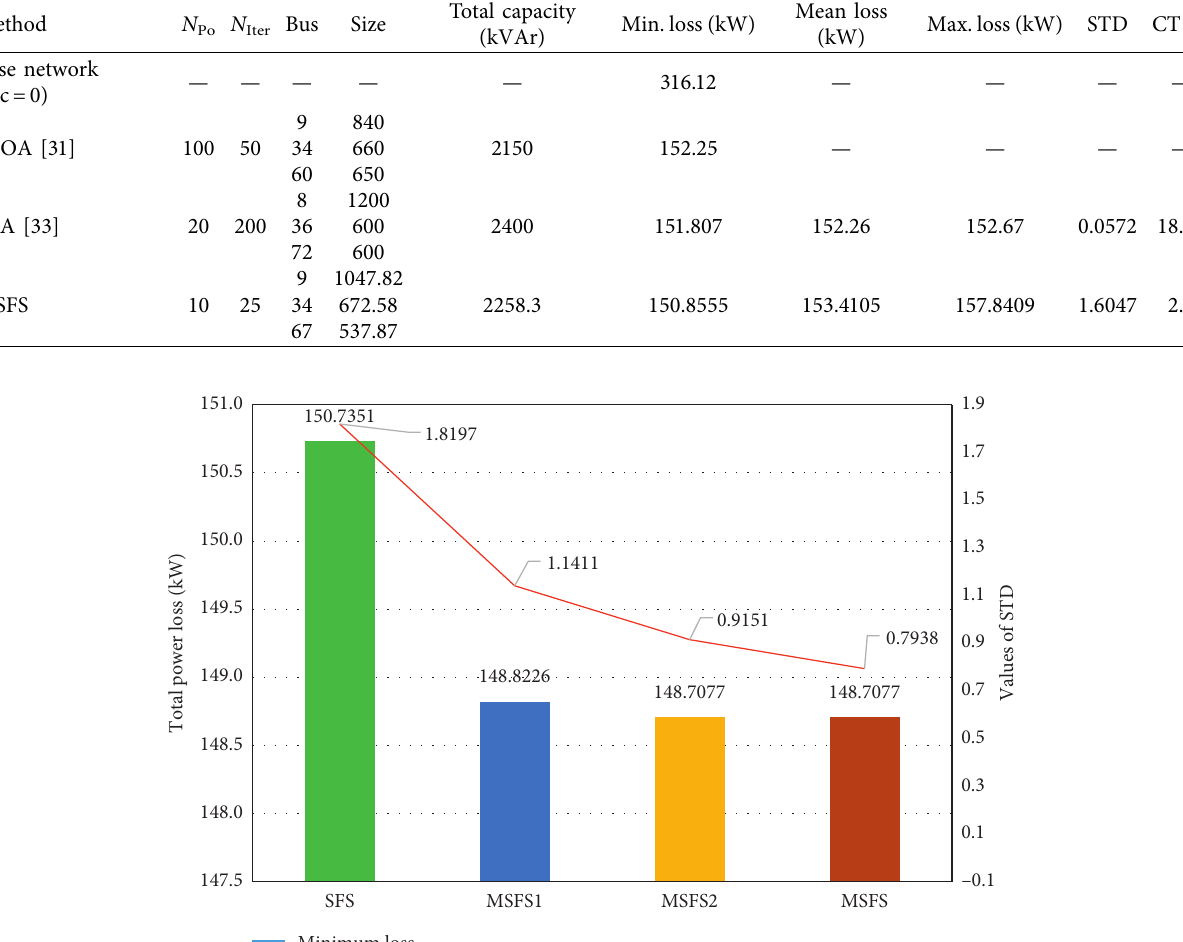
Table 8: Comparison with other methods for case 2 of the 85-bus system.